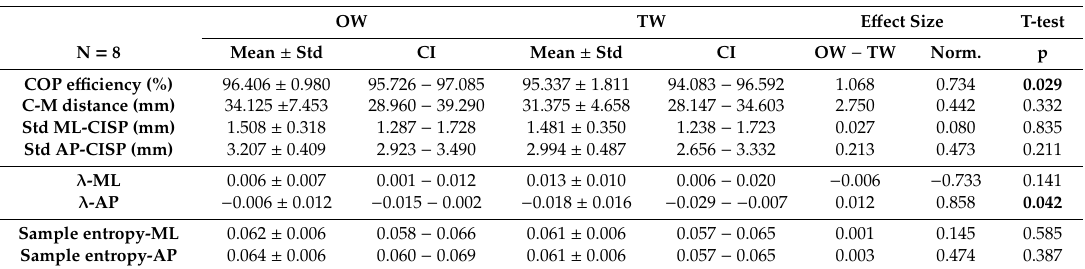
Table 6. Comparison of gait’s COP features during stance phase in ML and AP directions between TW and OW condition.